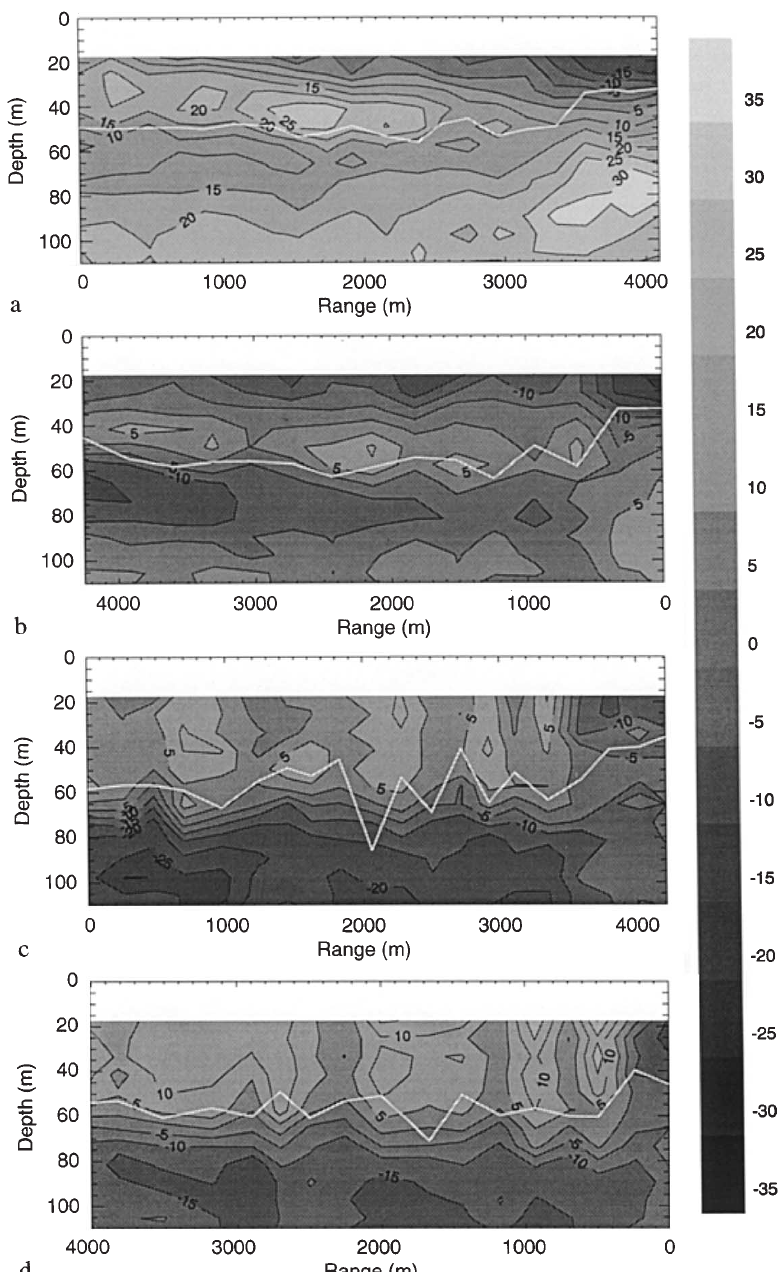
Fig. 7a–d. Raw eastward currents from ADCP for the four surveys of Fig. 5, shown as a function of range. Overplotted is the 12 (cid:176) C isotherm from the thermistor chain data sub-sampled to the ADCP resolution. Velocities in cm s )